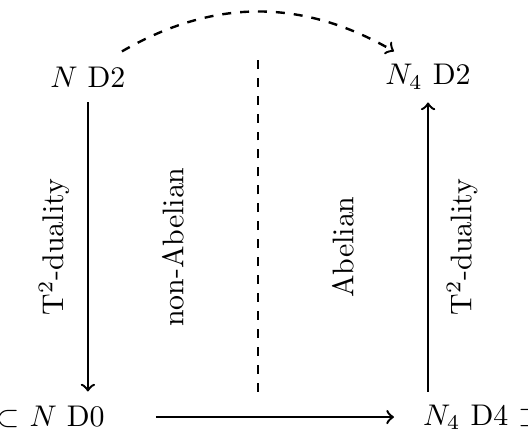
Figure 1 . The summary of our